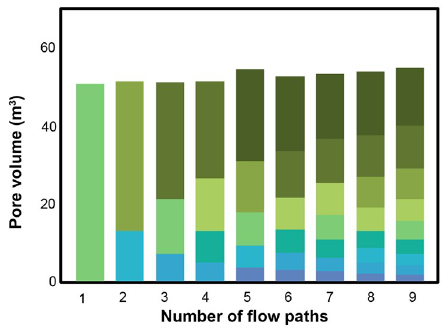
Figure 9. Pore volume calculated from tracer response curve from Fenton Hill HDR reservoir.